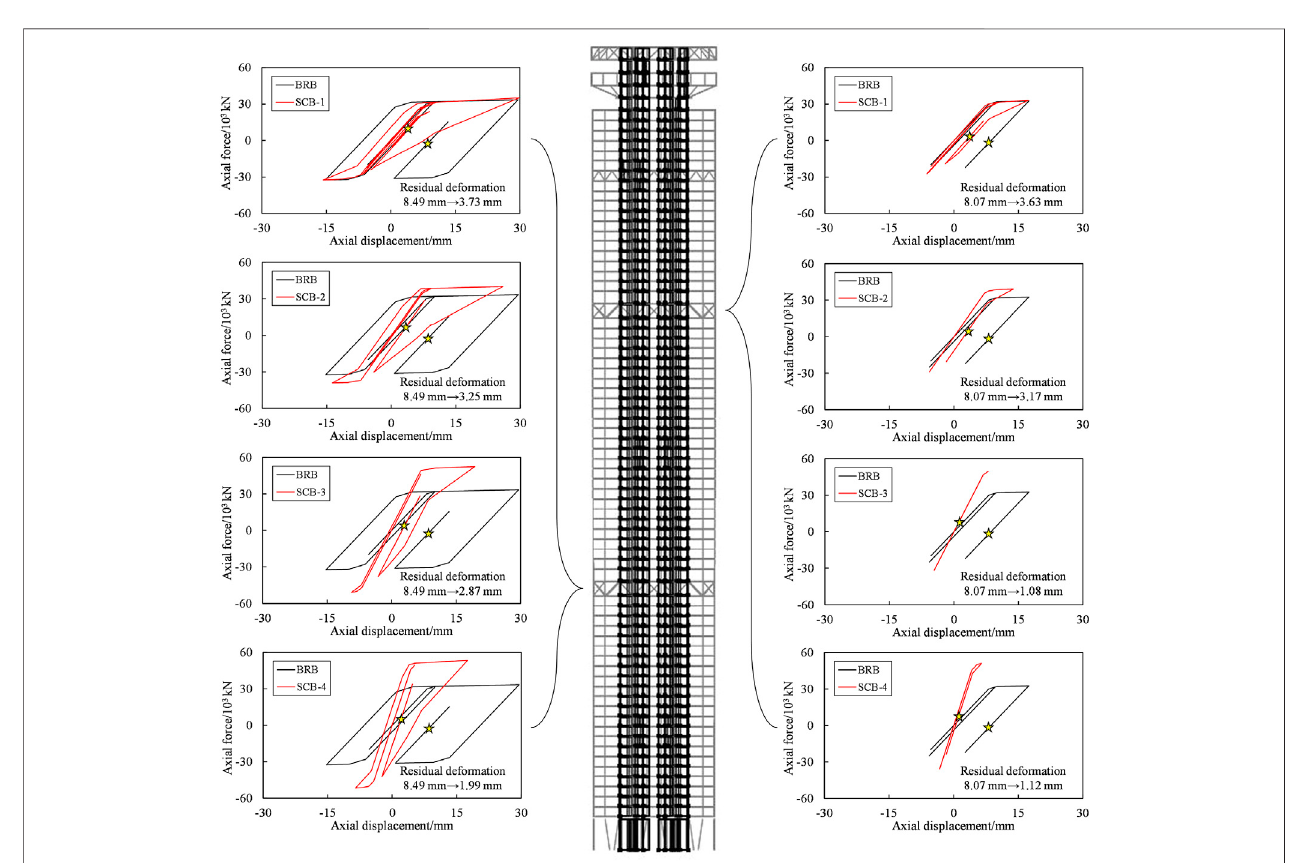
FIGURE 12 | Comparison of the hysteretic curves and residual deformation of web members in an outrigger.